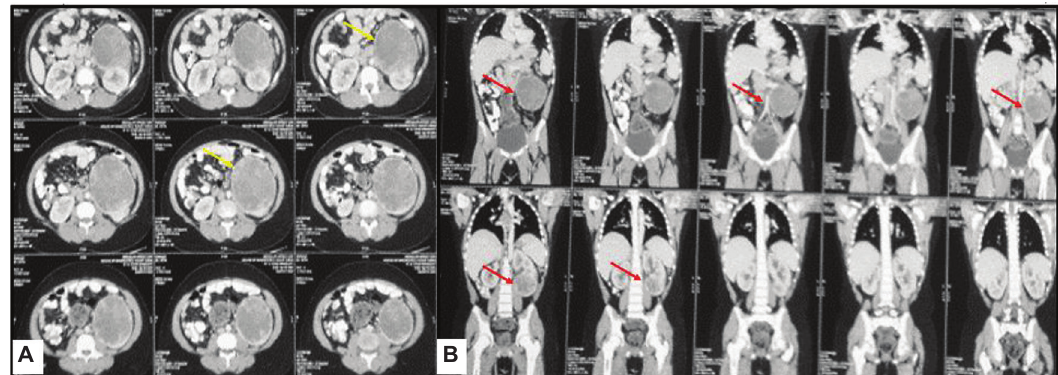
Figure 3: Images of (A) axial and (B) coronal CECT of the abdomen reveal exophytic heterogeneously enhancing solid mass (arrow) arising from the left kidney. The mass has no fat component in